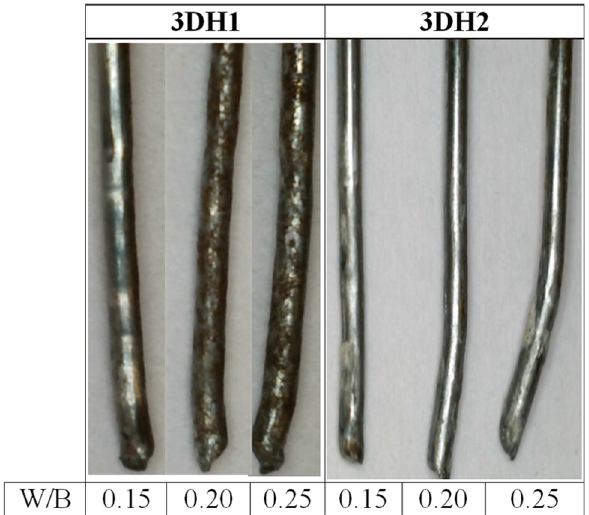
Fig. 9 Image shows the comparison between 3DH1 and 3DH2 fibres after pullout.